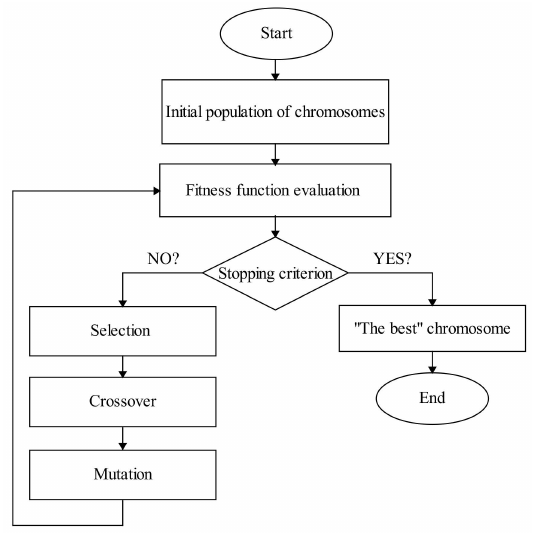
Figure 3. Basic steps of the genetic